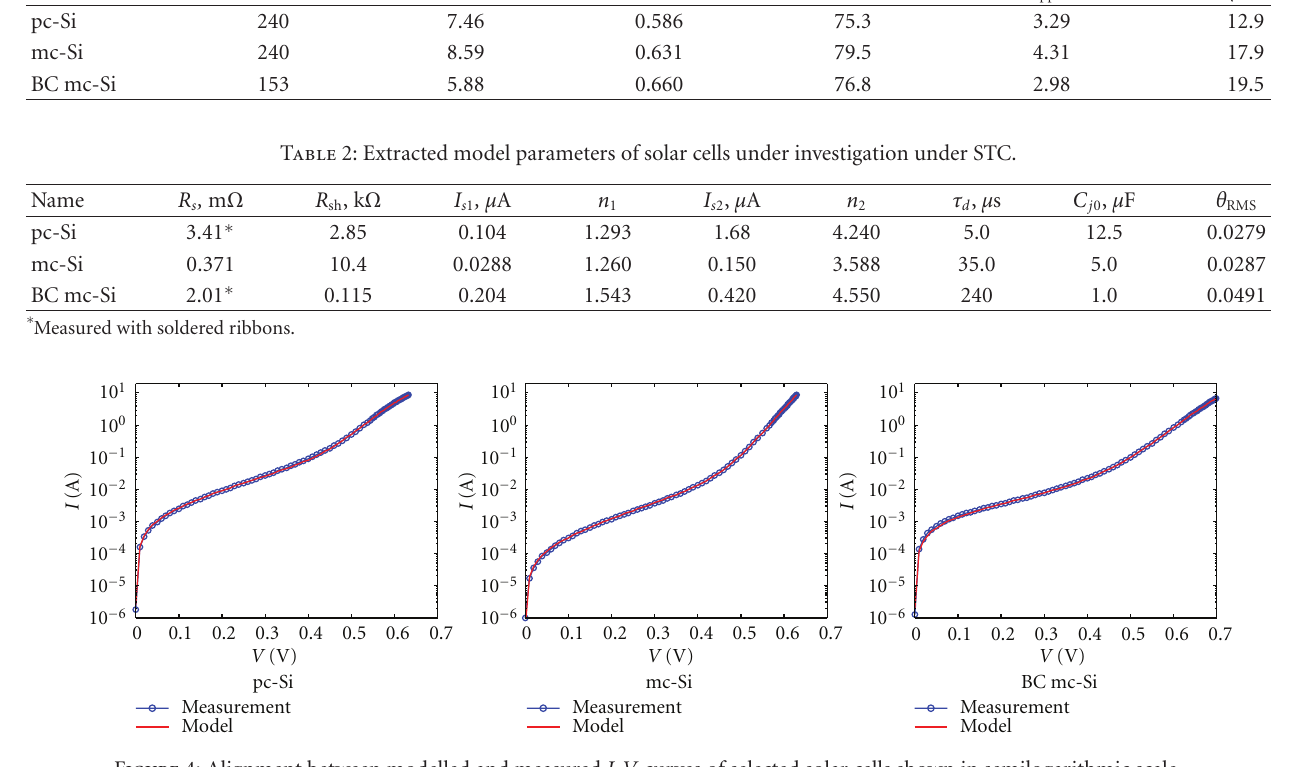
0 0.5 1 1.5 2 2.5 3